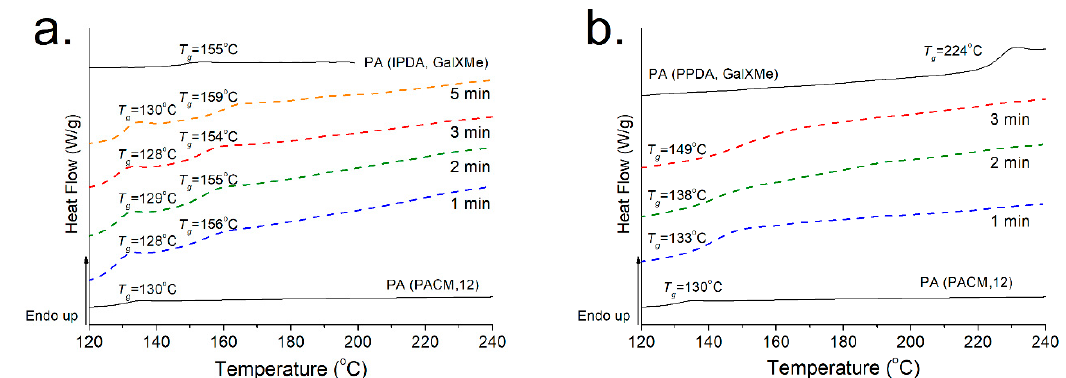
Figure 5. DSC curves for blends of homopolyamides with PA(PACM,12) representing heat flow (W/J) with endothermic exchange up and the variation of the profiles as a function of the processing time. ( a ) PA(PACM,12) 50 PA(IPDA,GalXMe) 50 and ( b ) PA(PACM,12) 50 PA(PPDA,GalXMe) 50.